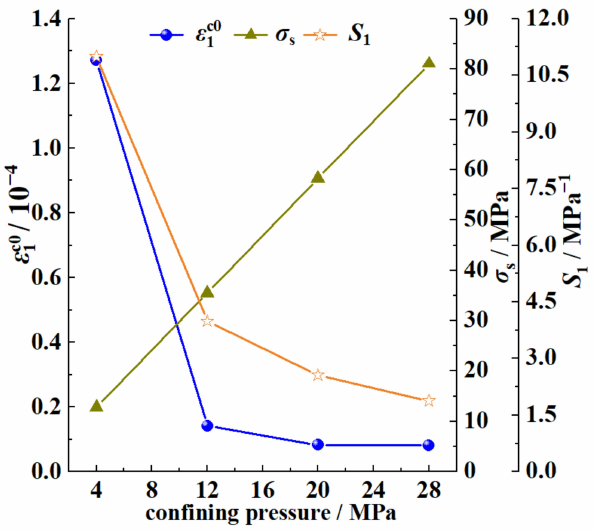
Figure 12. Curve of fitting parameters changing with confining